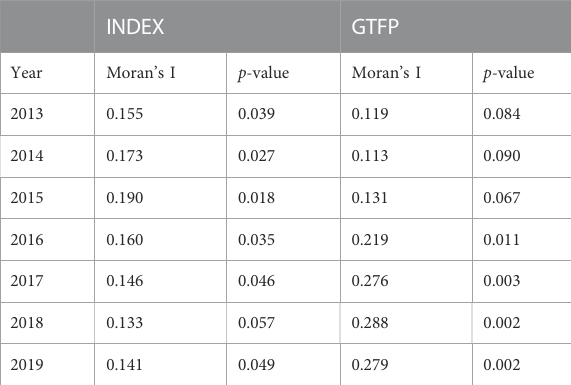
TABLE 2 Global Moran ’ s